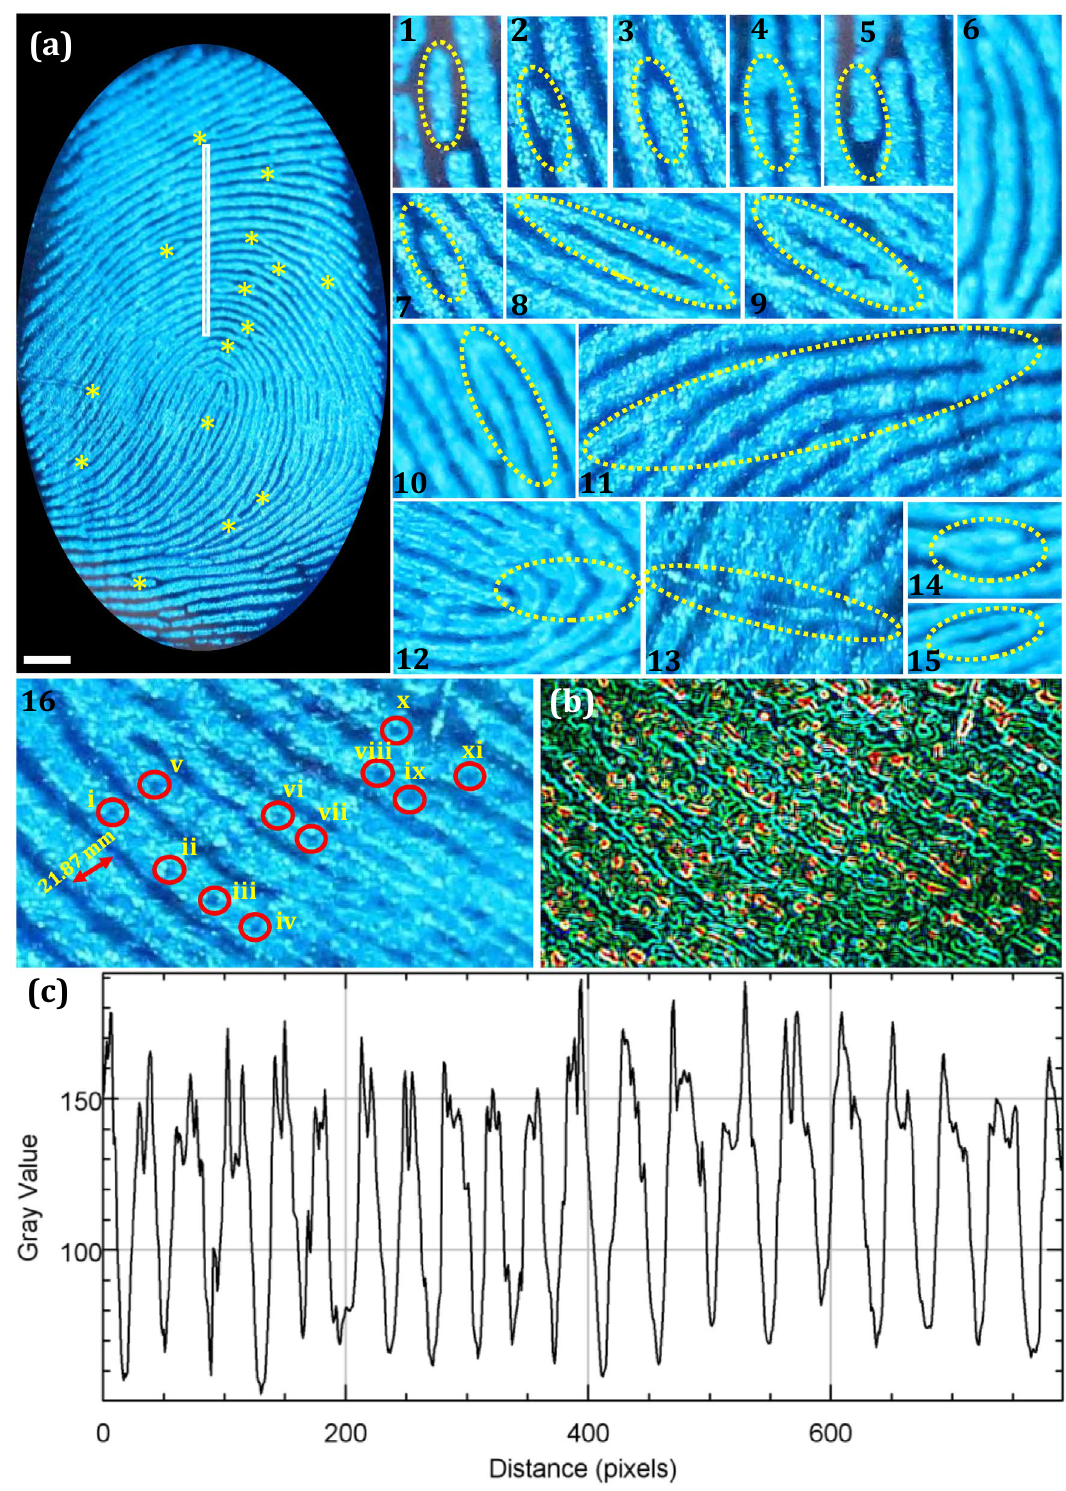
Figure 8. ( a ) High resolution FP image along with extracted ridge features including level I, level II and level III (1–16) on the glass surface visualized by FDIP solution followed by spray method under UV 365 nm illumination. The corresponding grayscale images were shown in Fig. S9; ( b ) interactive plot of the portion of the FP to show the distribution of sweat pores on the ridges of the FP; ( c ) fluctuations in the gray value over the FP indicated by the white bar in the ( a ) (Scale bar: 5